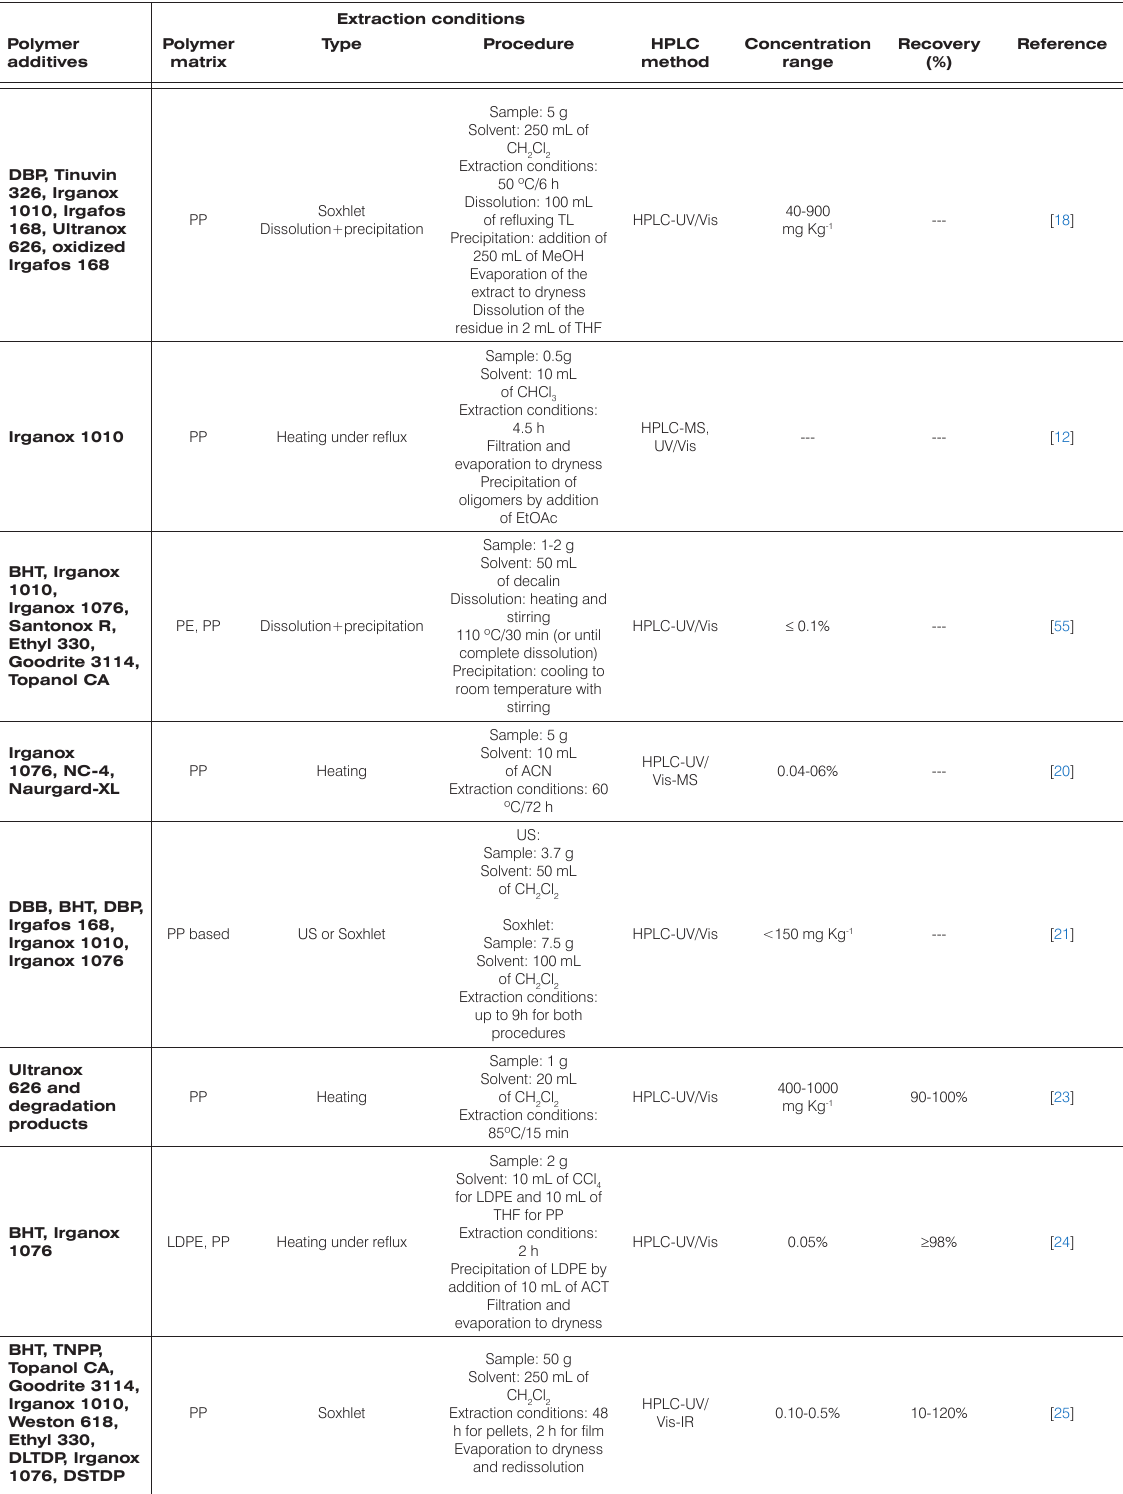
Extraction conditions